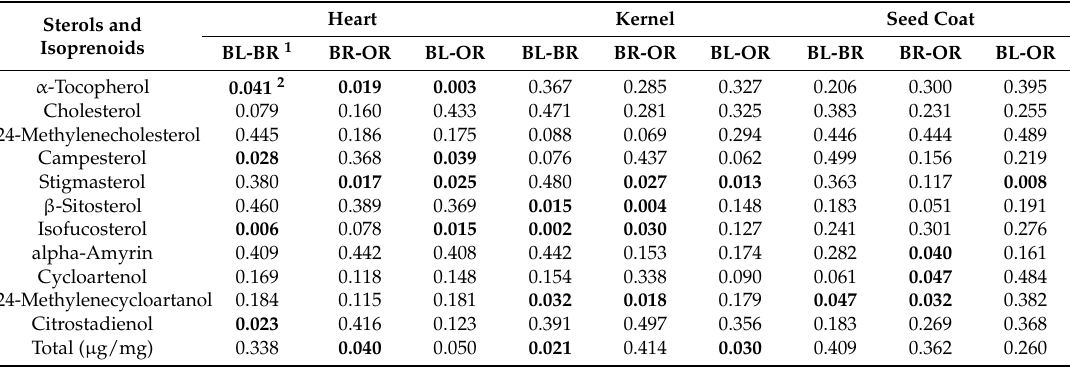
Table 5. The p -values of the pair-wise Student’s t -test among three developmental stages. Sterols and